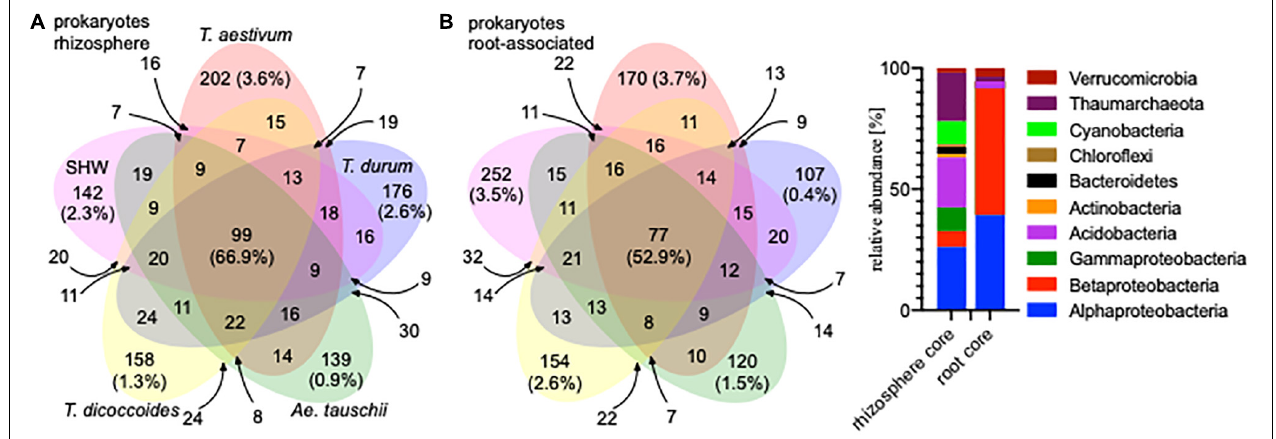
FIGURE 2 | Venn diagrams of the prokaryotic microbiota from different wheat species in (A) rhizosphere and (B) root-associated niches showing the number and relative abundance of prokaryotic OTUs. Only OTUs that were found in both lines representing a species were analyzed. For the small overlapping regions, the OTU numbers are indicated with arrows. Core microbiota profile of the rhizosphere and root-associated community is